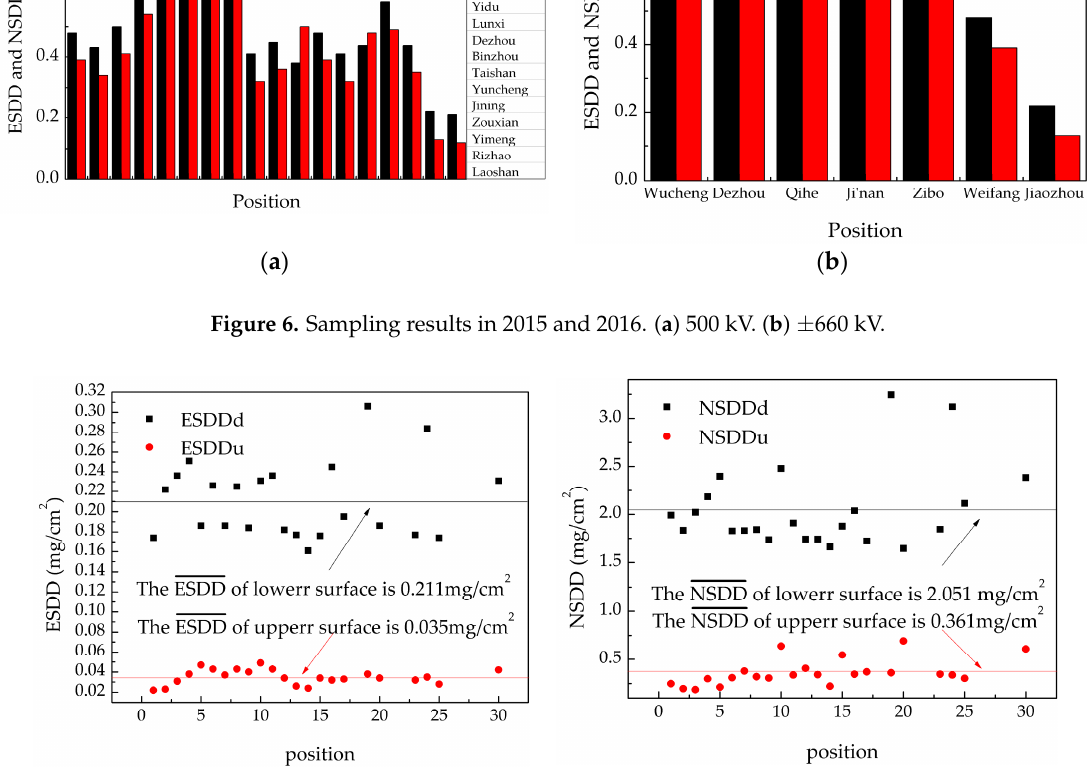
Figure 7. The contamination of HVDC(+). ( a ) The results of equivalent salt deposit density (ESDD). ( b ) The results of non-soluble deposit density (NSDD).